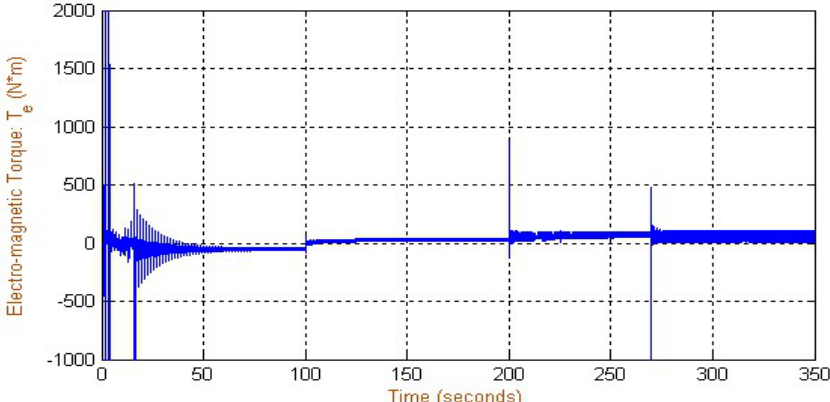
Figure 21. Electromagnetic torque versus time.